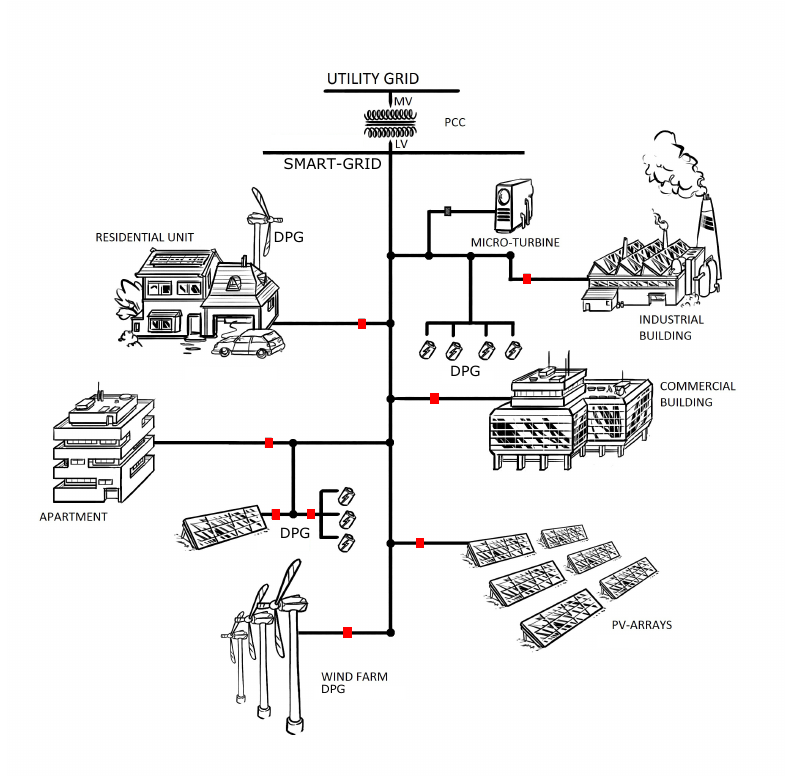
Figure 1. Smart-grid schematic. Power routers are distributed throughout the smart-grid (red blocks) partitioning it into smaller parts called